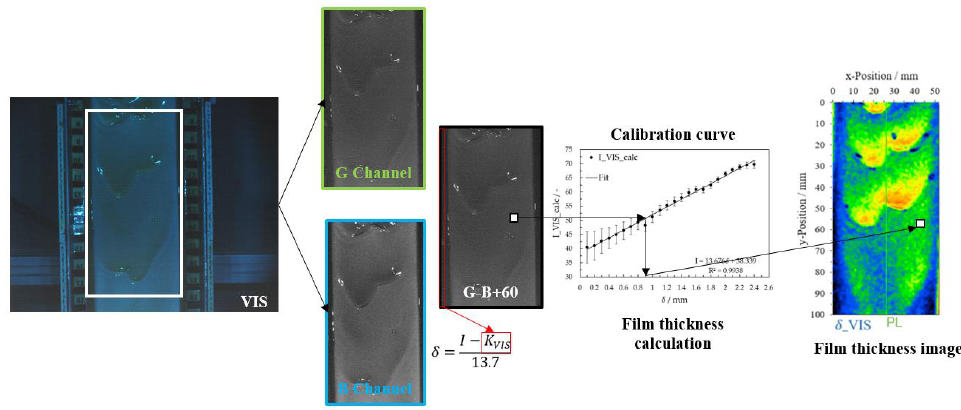
Figure 6. Calibration curves for film thickness calculation with the VIS images.